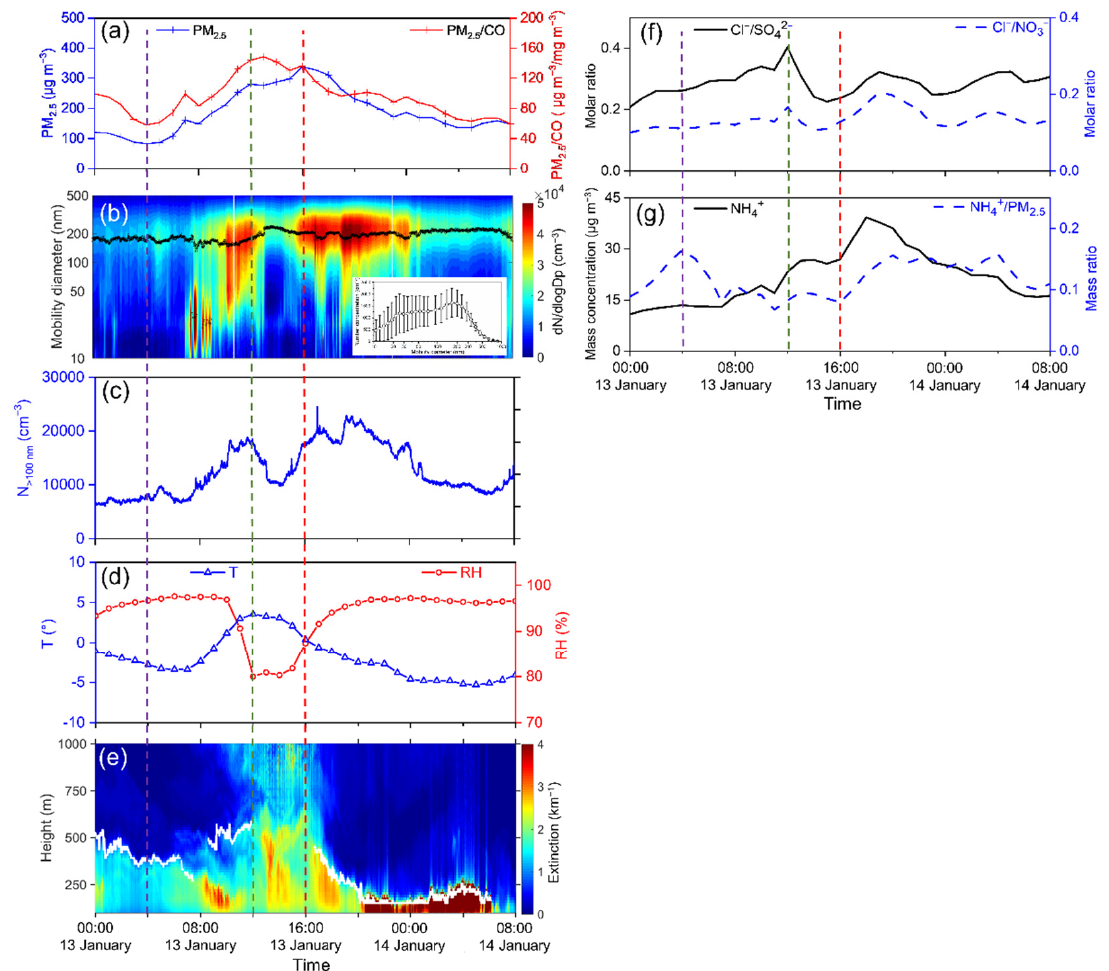
Figure 5. Temporal variations in different variables on 13–14 January 2019 in Qingdao, China: ( a ) time series of hourly average mass concentrations of PM 2.5 and PM 2.5 /CO ratios in µg m –3 /mg m –3 ; ( b ) contour plot of particle number concentration (dN/dlogDp), and particle size distribution during 4:00–12:00 on 13 January, black line represents GMMD of accumulation mode; ( c ) time series of N >100 nm ; ( d ) time series of T and RH; ( e ) planetary boundary layer height (white line) and extinction of aerosols based on the radar signal; ( f ) time series of molar ratios of SO 42– /Cl – and NO 3– /Cl – ; and ( g ) time series of NH 4+ concentrations in PM 2.5 and ratios of mass NH 4+ /PM 2.5 .